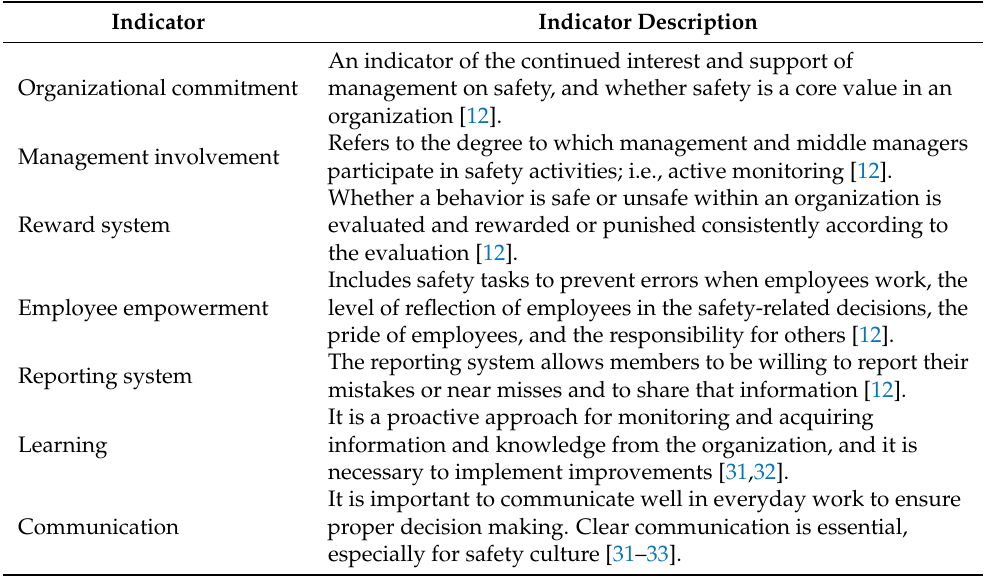
Figure 3. Relationship between the International Safety Management (ISM) Code and safety culture factors (Source: adopted from [8]). Table 3. Description of the seven safety culture indicators (Source: adopted from